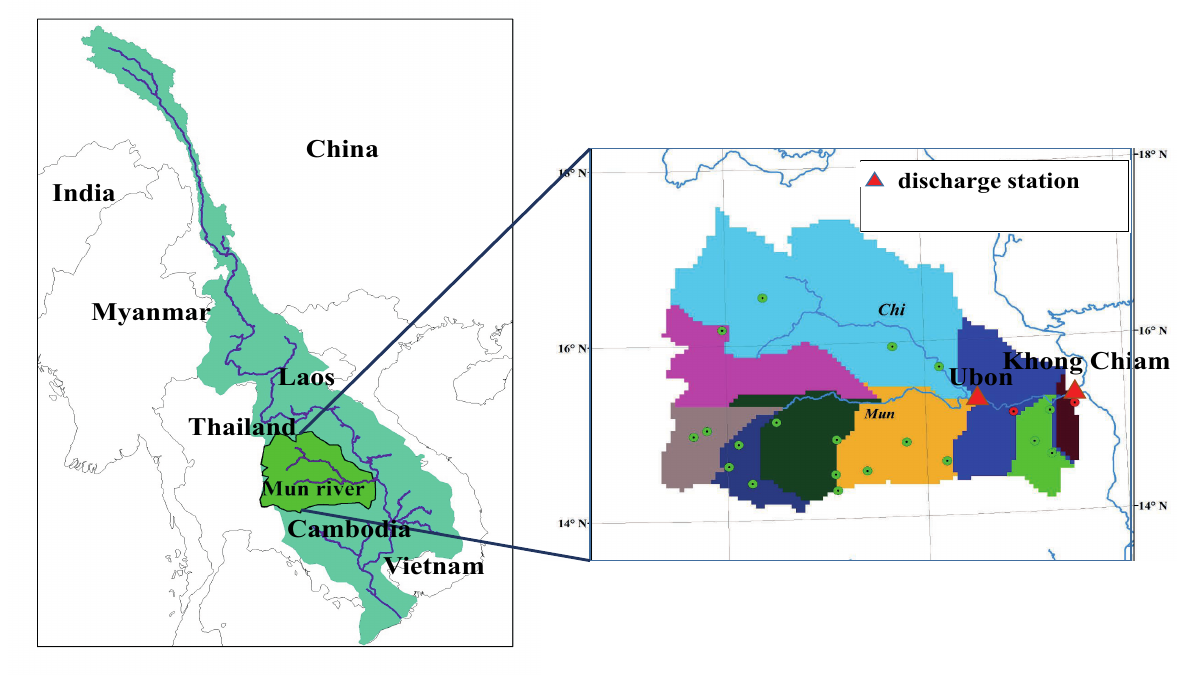
Fig. 1 Map of the Mun River